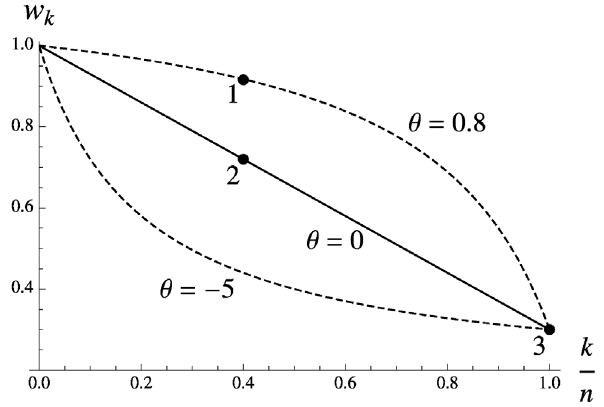
Figure 2. Genotype fitness as a function of the block length. The fitness of the genotype w k is plotted against the proportion of the occupied by the foreign genes: h ~ 0 corresponds to chromosome k n additive fitness (no epistasis), while h ~{ 5 and h ~ 0 : 8 represent the positive and the negative epistasis, correspondingly. The points indicate the fitness of the initial block carrying 4 genes k p ~ 4 ð Þ at h ~ 0 : 8 . Point 1: n =10, fitness is calculated according to eq. 12. Point 2: n =10, fitness is rescaled by the length of the initial block. Point 3: initial block carries the maximum number of genes, k p ~ n ~ 4